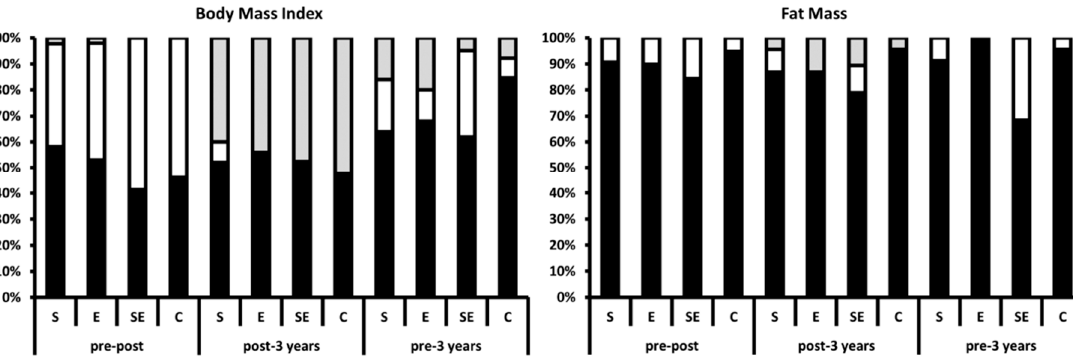
Figure 3 . Frequency of participants who maintained (black column), decreased (white column), or increased (gray column) their body weight status according to their body mass index (left panel) and fat mass (right panel) by group. Pre–post: changes between pre-intervention and post-intervention (6 months); post–3 years: changes between post-intervention and 3 years (3 years’ follow-up); pre–3 years: changes between pre-intervention and 3 years after intervention (3 years and 6 months).